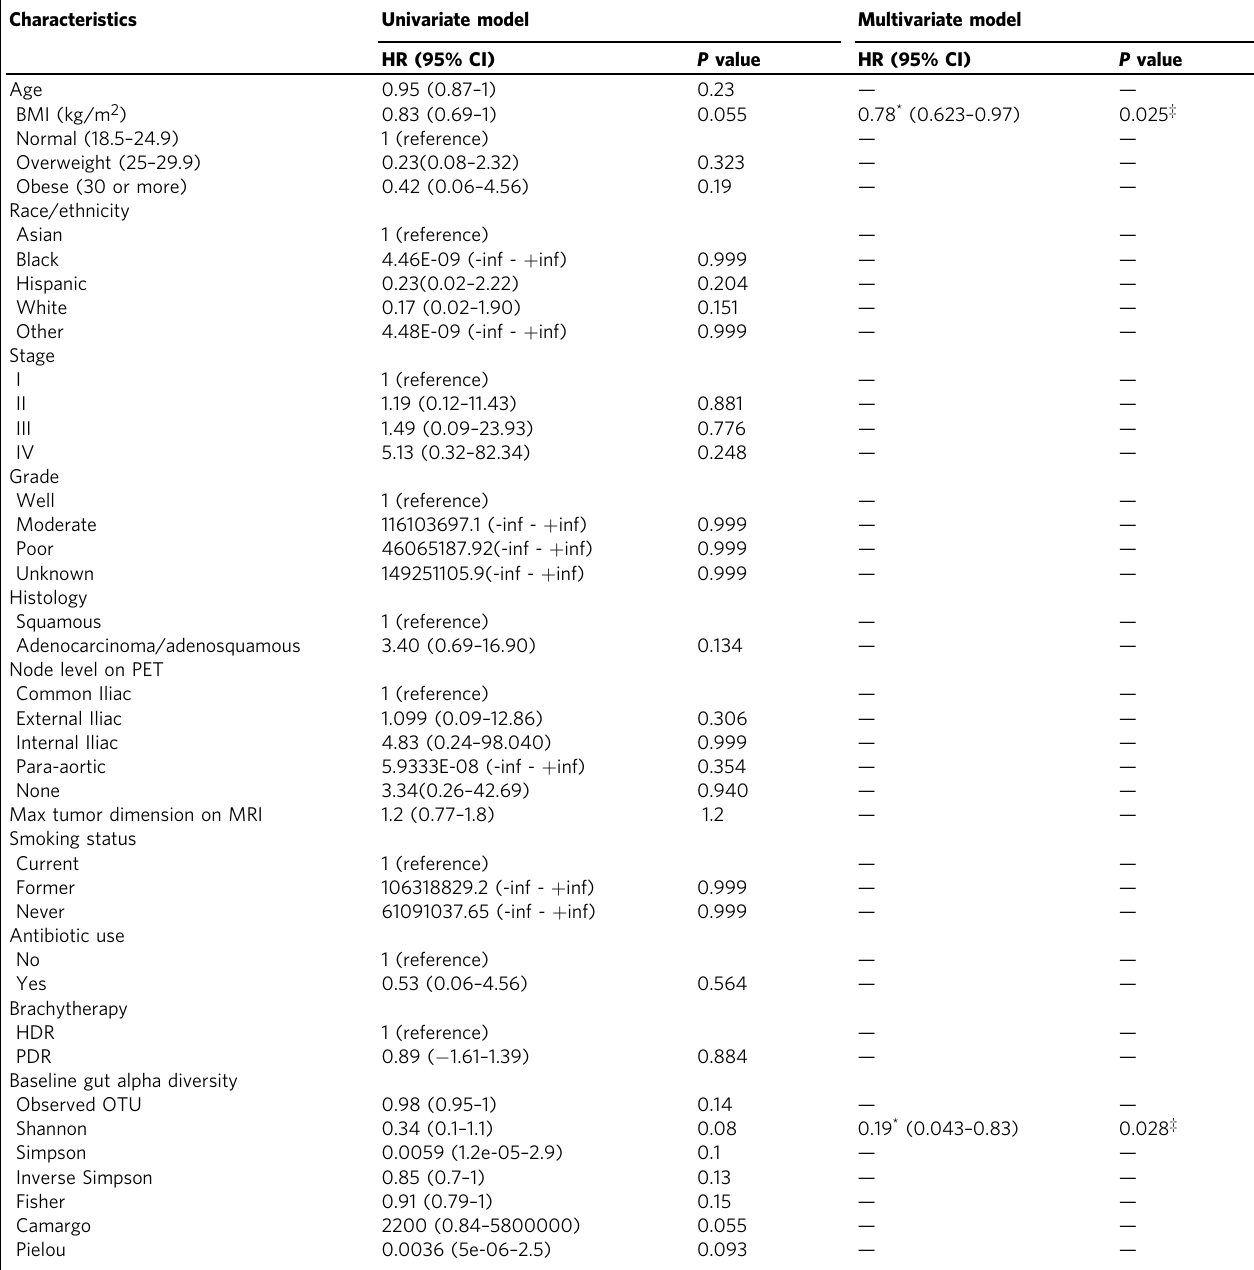
Table 2 Univariate and multivariate Cox regression analysis for overall survival.